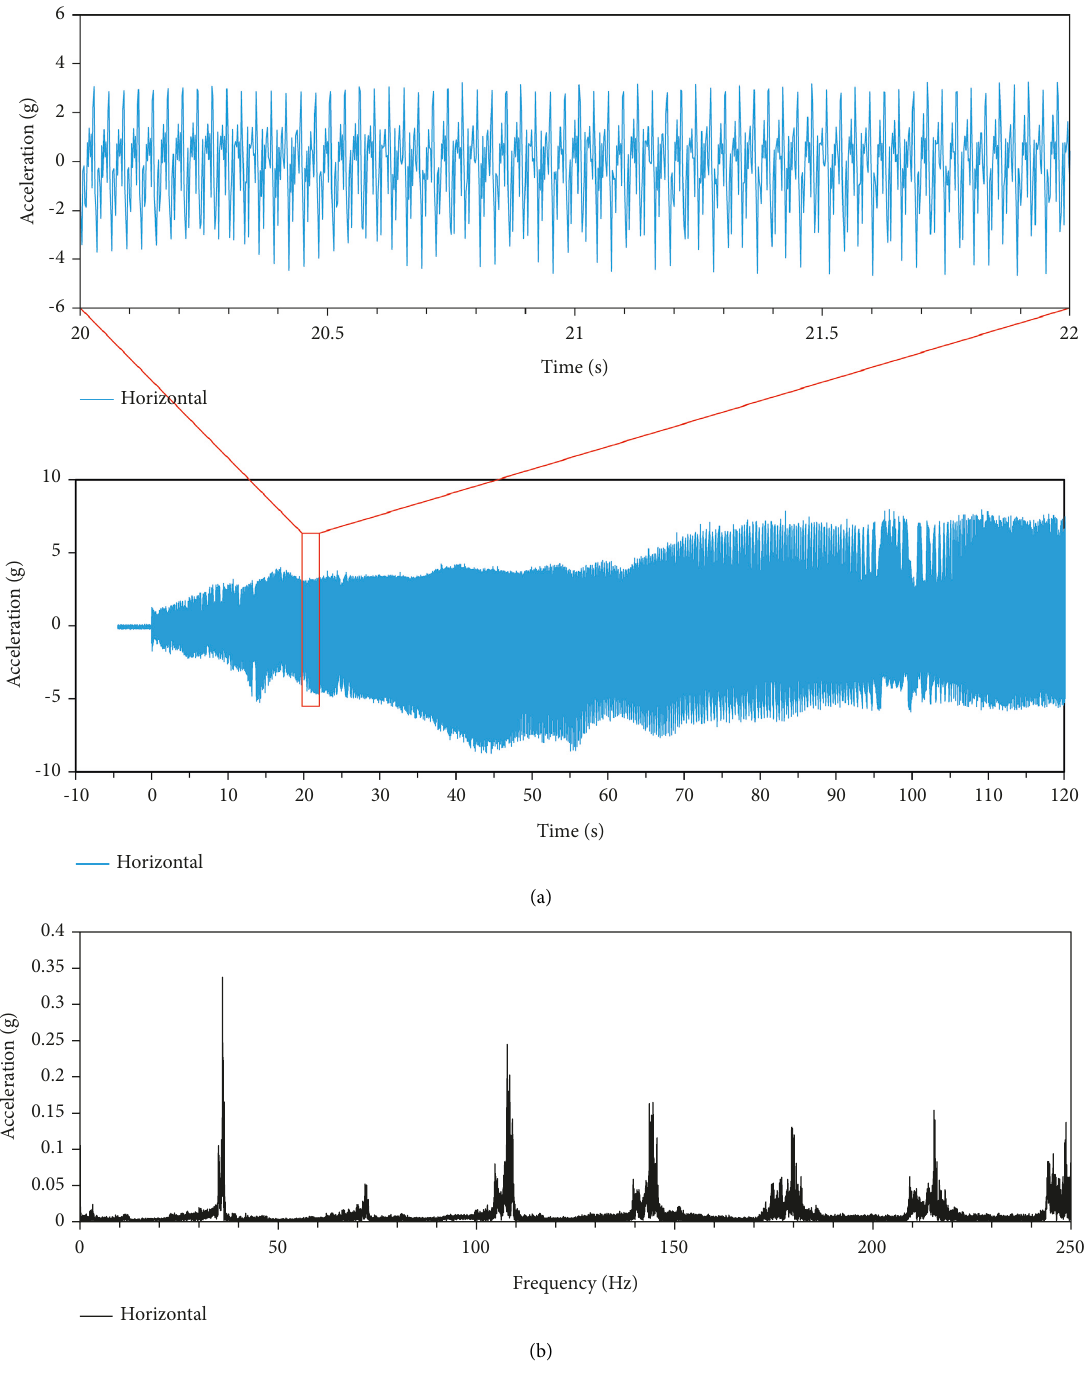
Figure 4: Measured input motion in both the (a) time and (b) frequency domains in test T